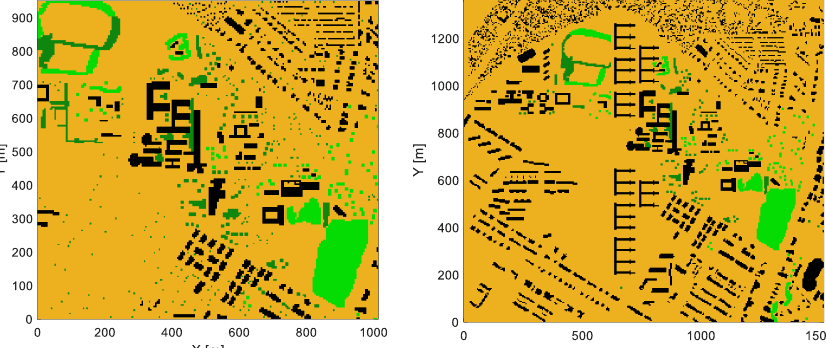
Figure 9. The domain employed in the ENVI-met simulations, with buildings (in black) and vegetation (pale green and dark green): on the left, the current situation (1020 m/204 cells in the X-direction, 920 m/191 cells in the Y-direction), on the right, the planned situation (1,525 m/305 cells in the X-direction, 1375 m/275 cells in the Y-direction).